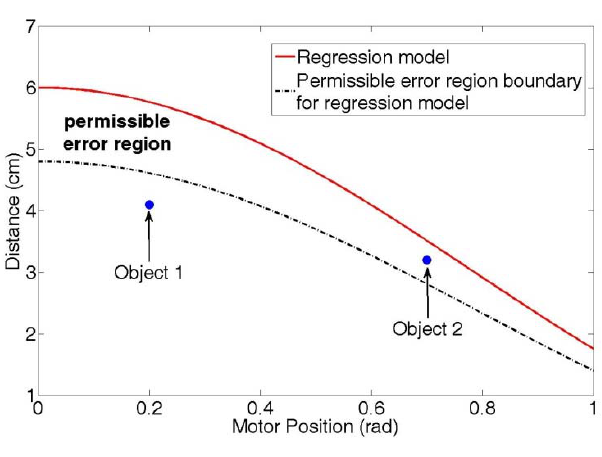
Figure 4. Permissible error